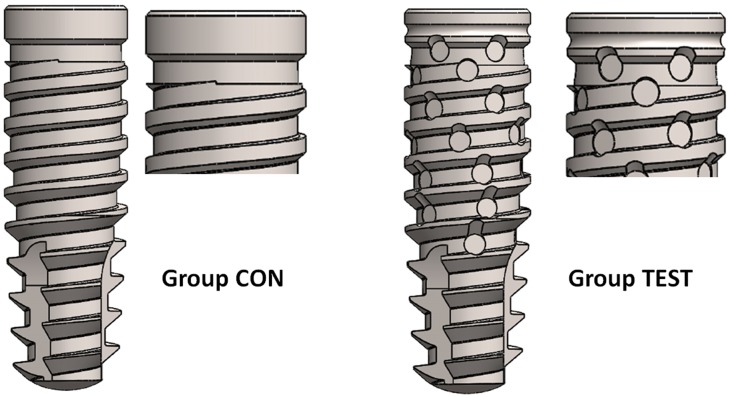
Schematic image of the implant models evaluated: The conventional implant macrogeometry (Group CON) and the new implant macrogeometry (Group TEST).